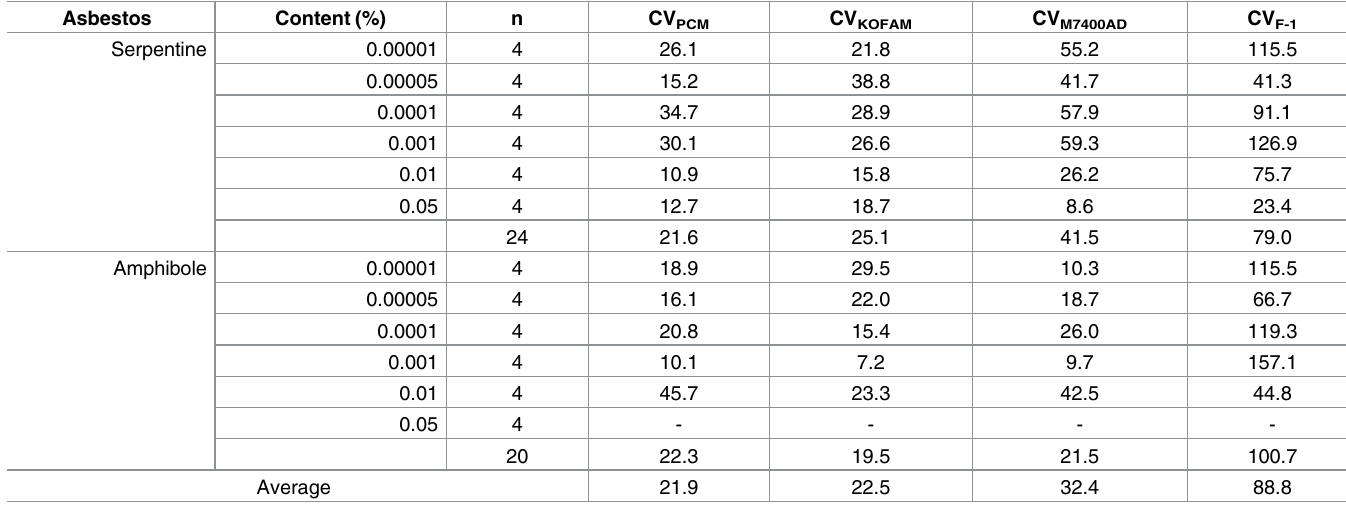
Table 4. Precision assessment of the KOFAM, M7400AD,and